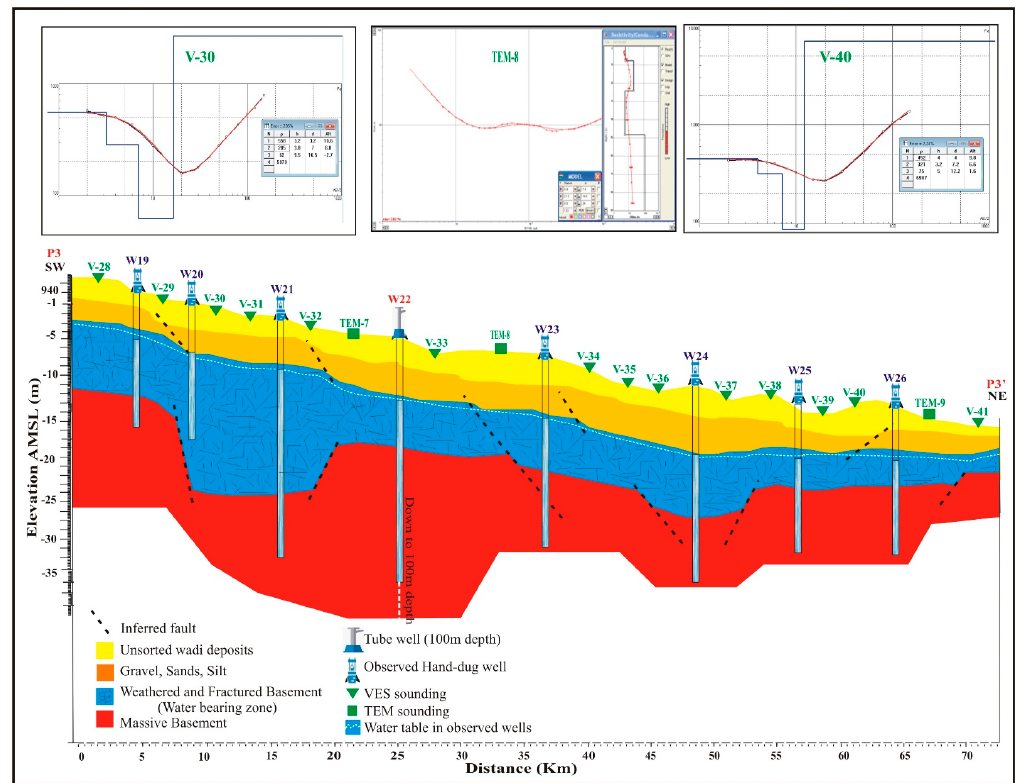
Figure 12. The geoelectric cross-section P2 ‒ P2’, with the sounding and the modeled data of VES (V- 14, and V-27) and TEM-6.